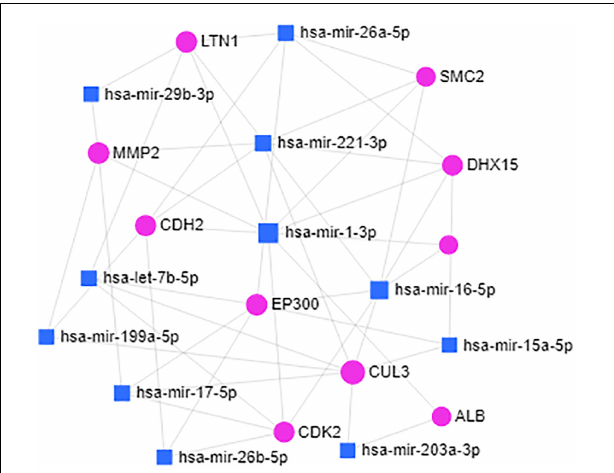
FIGURE 9 | miRNA–target regulatory network. The blue square represents miRNAs targeting the real hub genes, and the red circle represents the real hub genes. The bigger the circle or square, the higher the